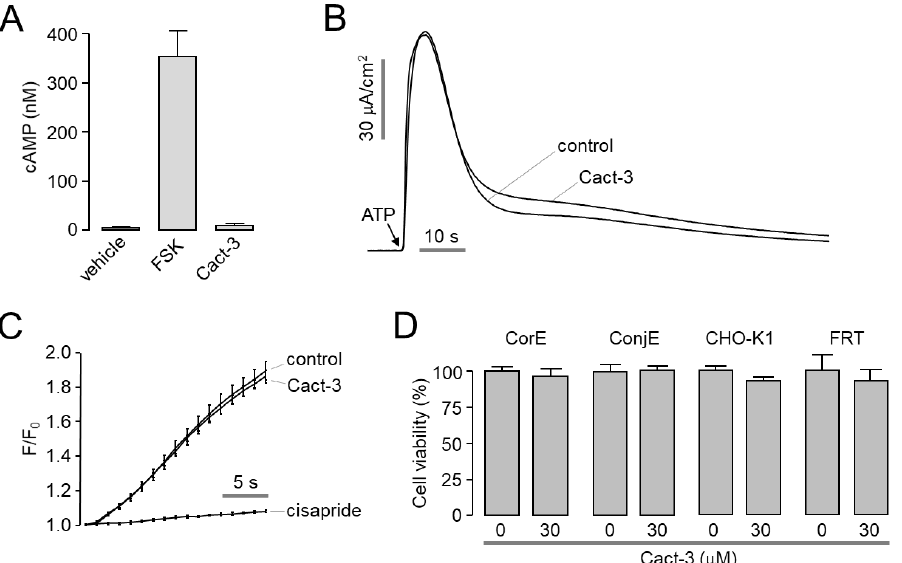
Figure 3. Effect of Cact-3 on cytosolic cAMP level, ANO1, hERG, and cell viability. ( A ) cAMP accumulation was measured in CHO-K1 cells. Cells were treated with forskolin (20 µ M) and Cact-3 (30 µM) for 10 min (mean ± S.E., n = 3). ( B ) Representative traces of apical membrane currents in FRT-ANO1 cells. Cact-3 was pretreated 10 min prior to activation of ANO1 by ATP (100 μM). ( C ) Effect of Cact-3 on hERG activity was measured using FluxOR assay in recombinant HEK293 cell line expressing hERG (mean ± S.E., n = 6). Cact-3 (30 μM) and cisapride (50 μM, a hERG inhibitor) were pretreated for 10 min. ( D ) CorE and ConjE cells were treated with 30 µM Cact-3 for 48 h and then cell viability was assessed by MTS assay (mean ± S.E., n = 6).